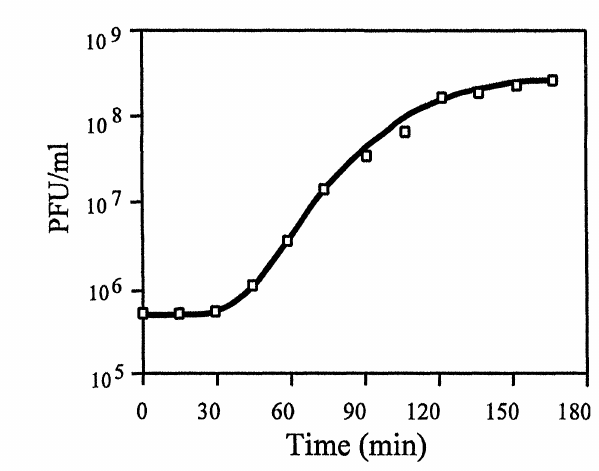
Fig. 2. One-step growth curve of vaginal Lactobacillus phage